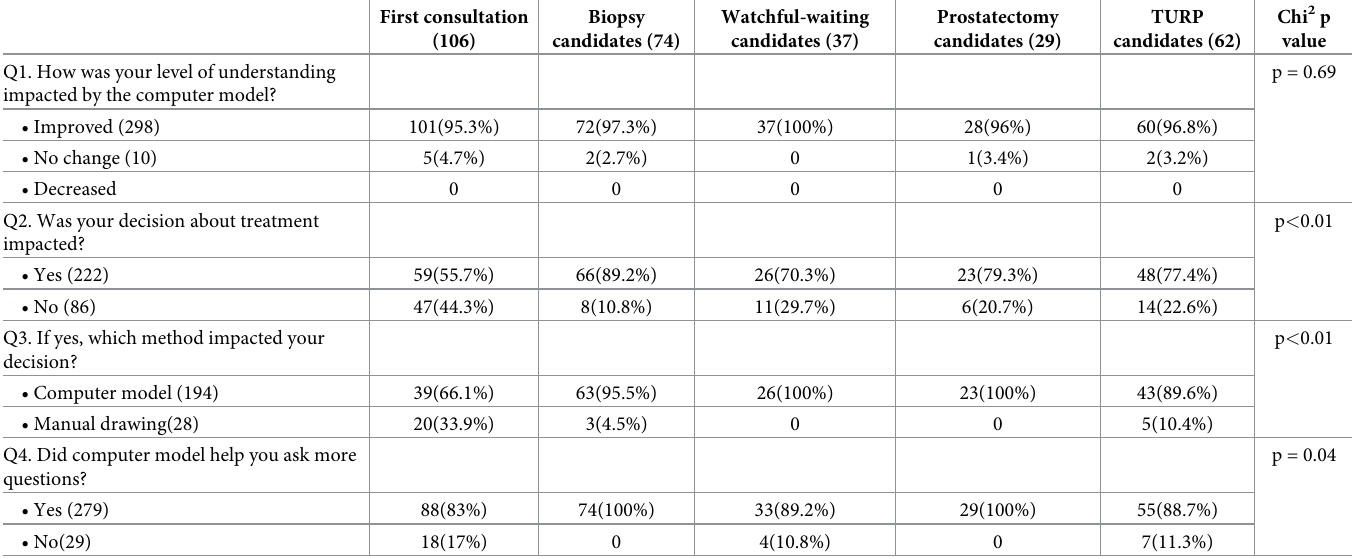
Table 3. Questionnaire for patients, broken down by referral